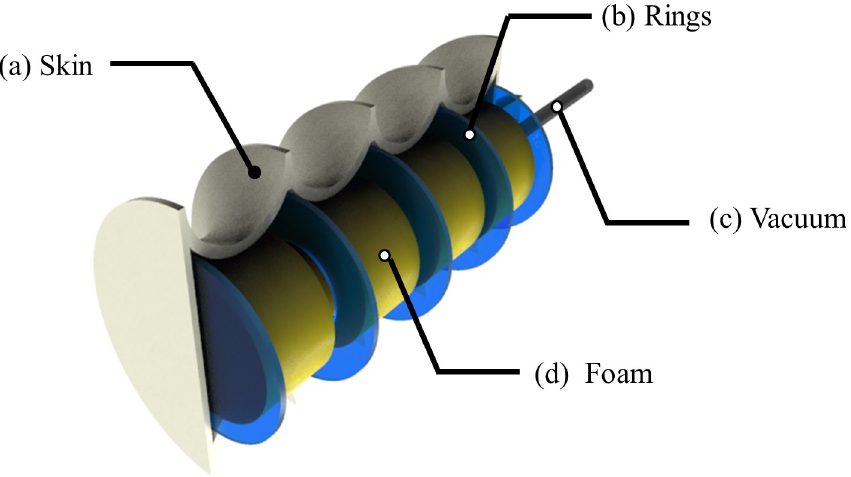
Fig 1. Concept design of the proposed pneumatic artificial muscle: (a) bellow-type skin; (b) rigid rings; (c) vacuum line; (d) open-cell foam cylinders.